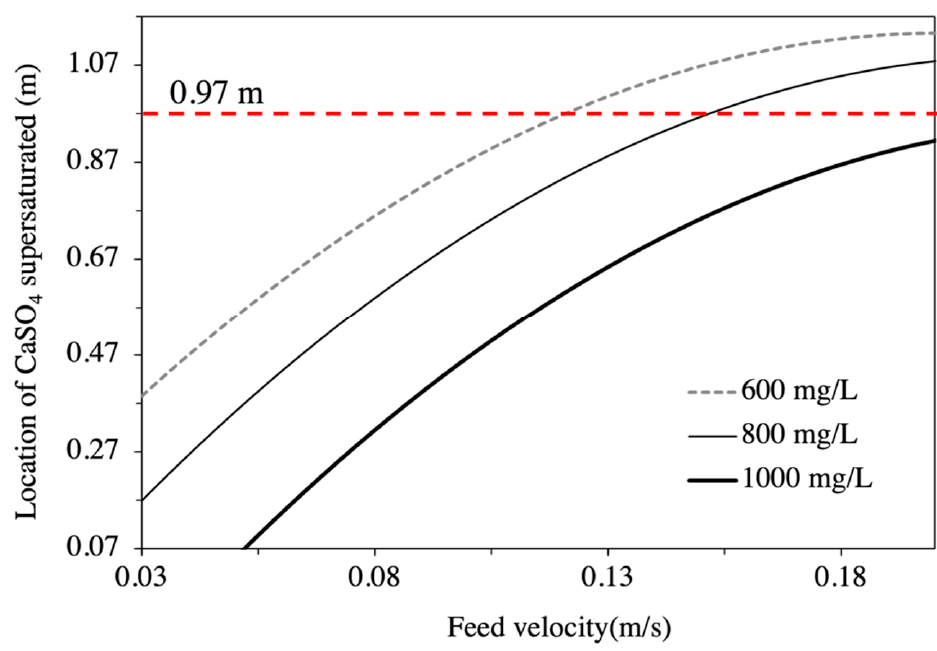
Figure 5. Position on RO element where CaSO 4 supersaturated at different feed conditions.